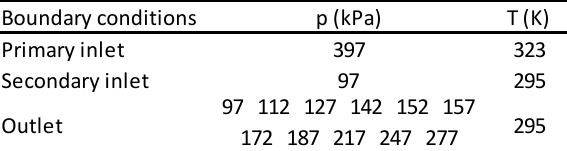
Table 2. Boundary conditions of the ejector